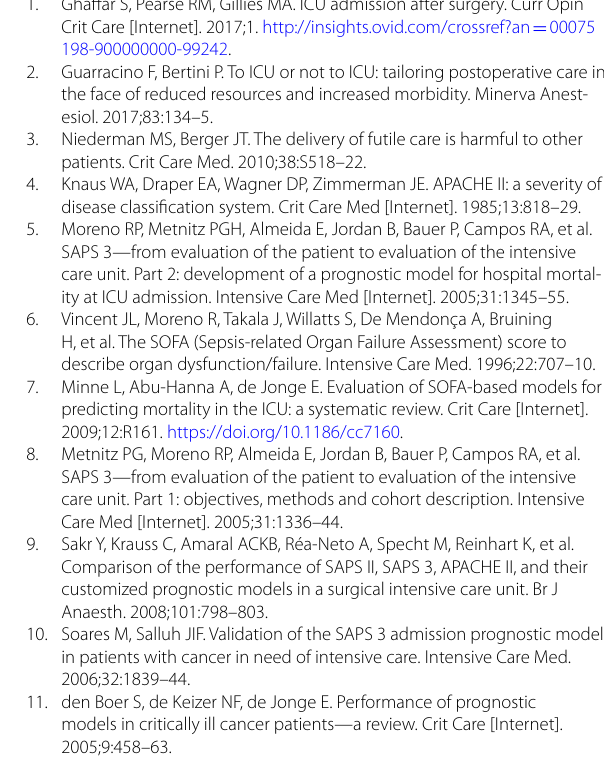
Additional file 1: Figure S1. STARD 2015 Checklist: Prediction Model Validation. Additional file 3: Figure S2. Prediction scores distribution frequency. A–F—Patients distribution across severity scores values with intra-ICU (A, C and E) and in-hospital (B, D and F) mortality as outcomes. Blue bars represent survivors and green bars